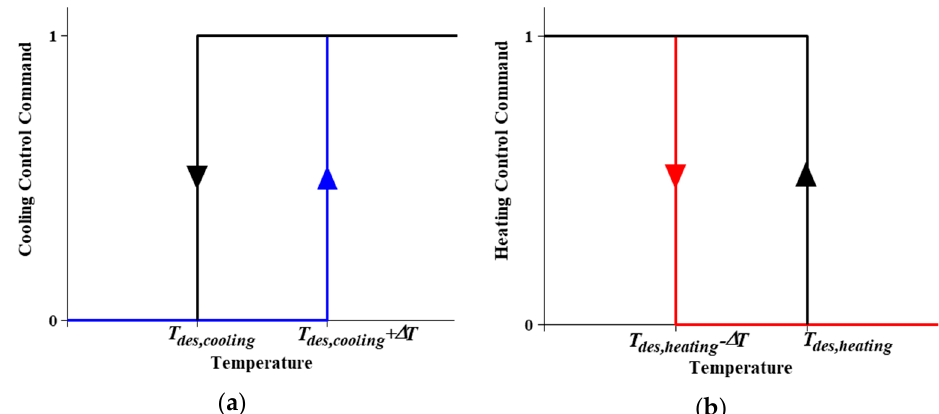
Figure 2. Control command of the heating, ventilation, and air-conditioning (HVAC) system based on acceptable temperature range: ( a ) cooling process and ( b ) heating process.